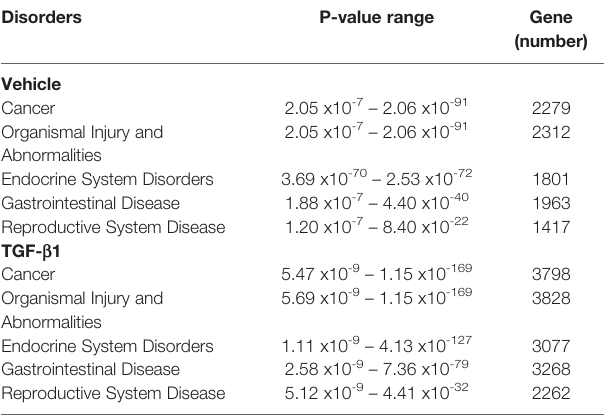
P-value (p <0.05) was obtained by comparing the expression levels of all genes that mediate these pathological processes in CFBE41o- cells transfected with siLMTK2 versus